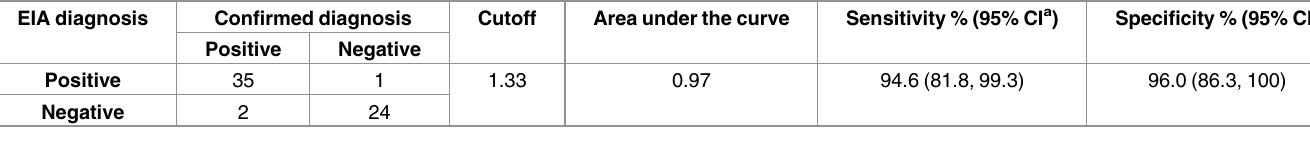
Table 1. Corresponding table for ROC curve